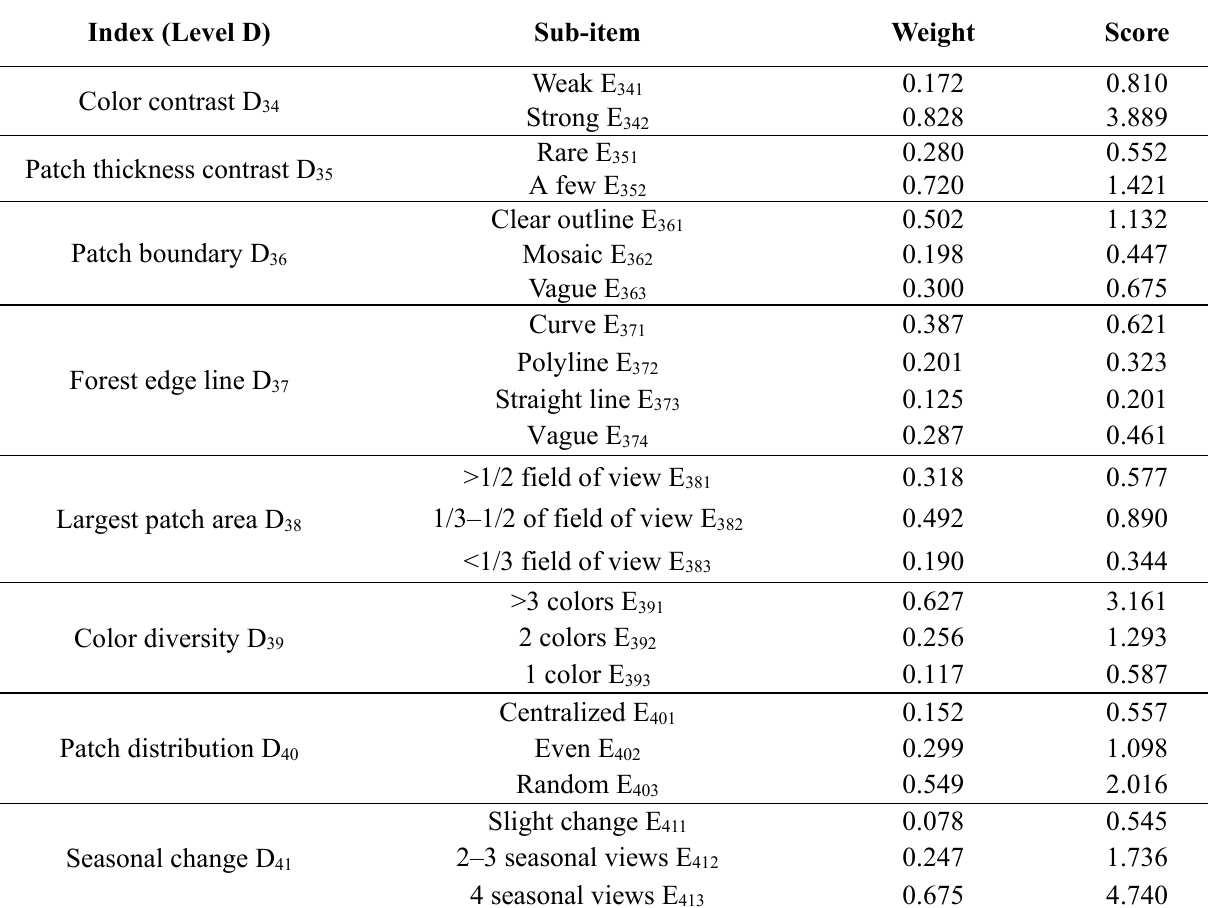
Table 6. Categories and scores of far-view forest landscapes.